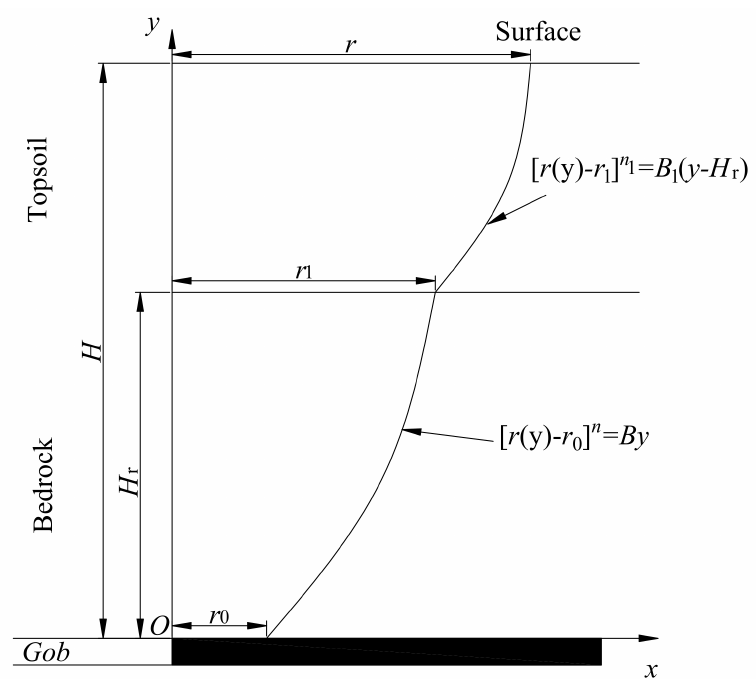
Figure 6. Movement boundary equations of bedrock and unconsolidated stratum.